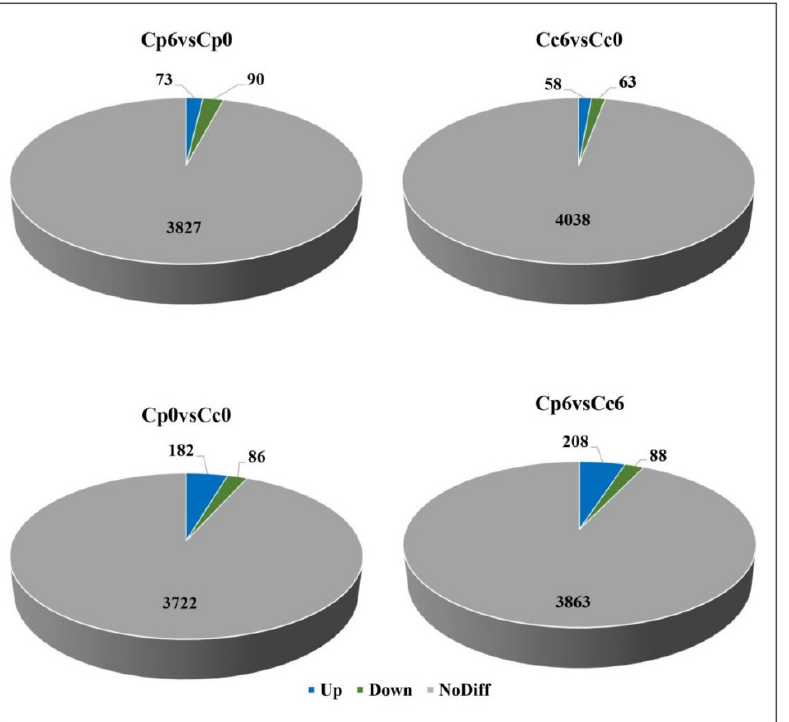
Figure 8. The overall number of differentially accumulated metabolites in the in the cold-treated C. pubescens and C. chinense pepper seedlings after 6 h of cold stress.